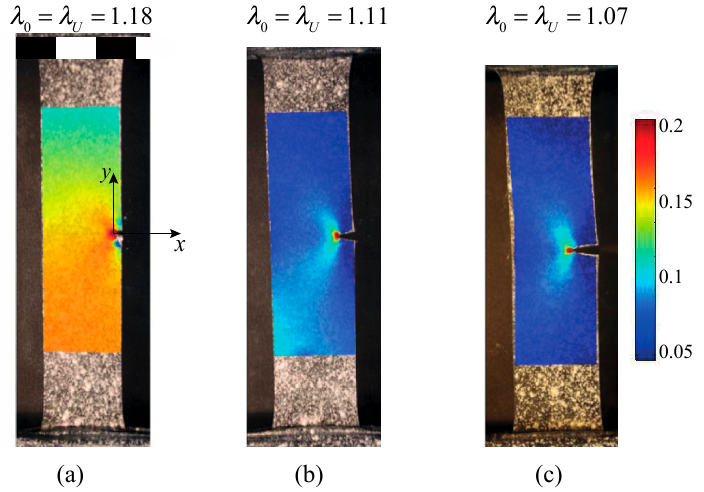
. ε  . The ε 0 ( 1 ) . The remote 0